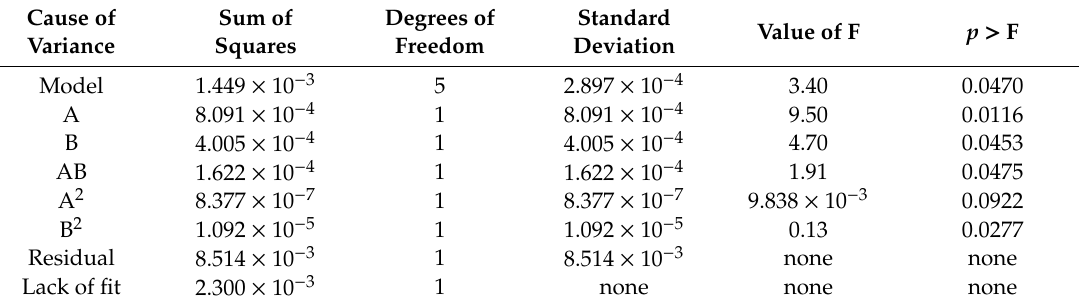
Table 3. Variance analysis.